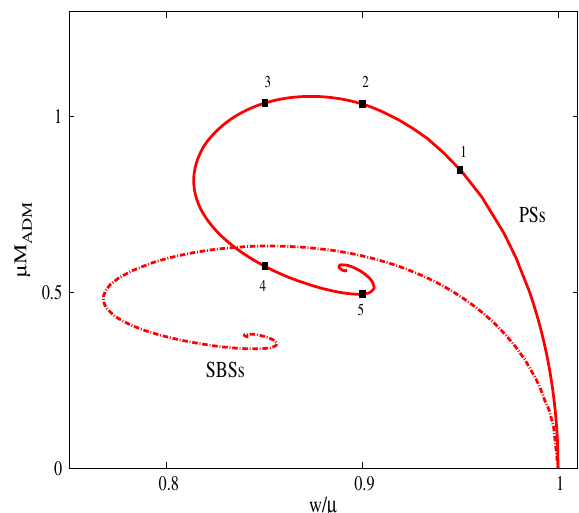
Fig. 10 Comparison of Proca solutions with boson stars. The ADM mass of spherical Proca solutions (solid) and scalar BS solutions (dashed) are shown versus oscillation frequency. Here, the mass is expressed in terms of the field mass, μ . Although the profiles are qualitatively similar, notice that the maximum mass of the Proca solutions is almost twice that of BSs. Reprinted with permission from Sanchis-Gual et